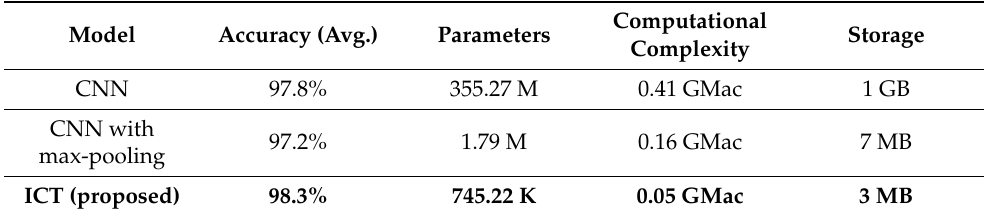
Table 5. Analytical comparison with state-of-art CNN architectures in terms of accuracy, computa- tional complexity and storage requirements.